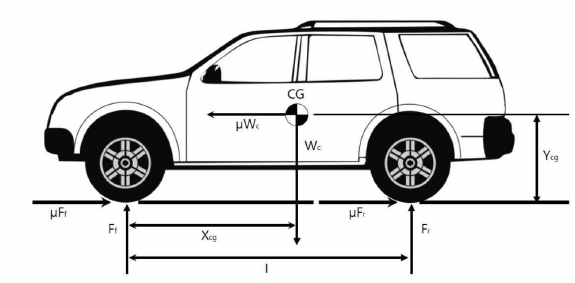
Figure 15. Distribution of vehicle weight.